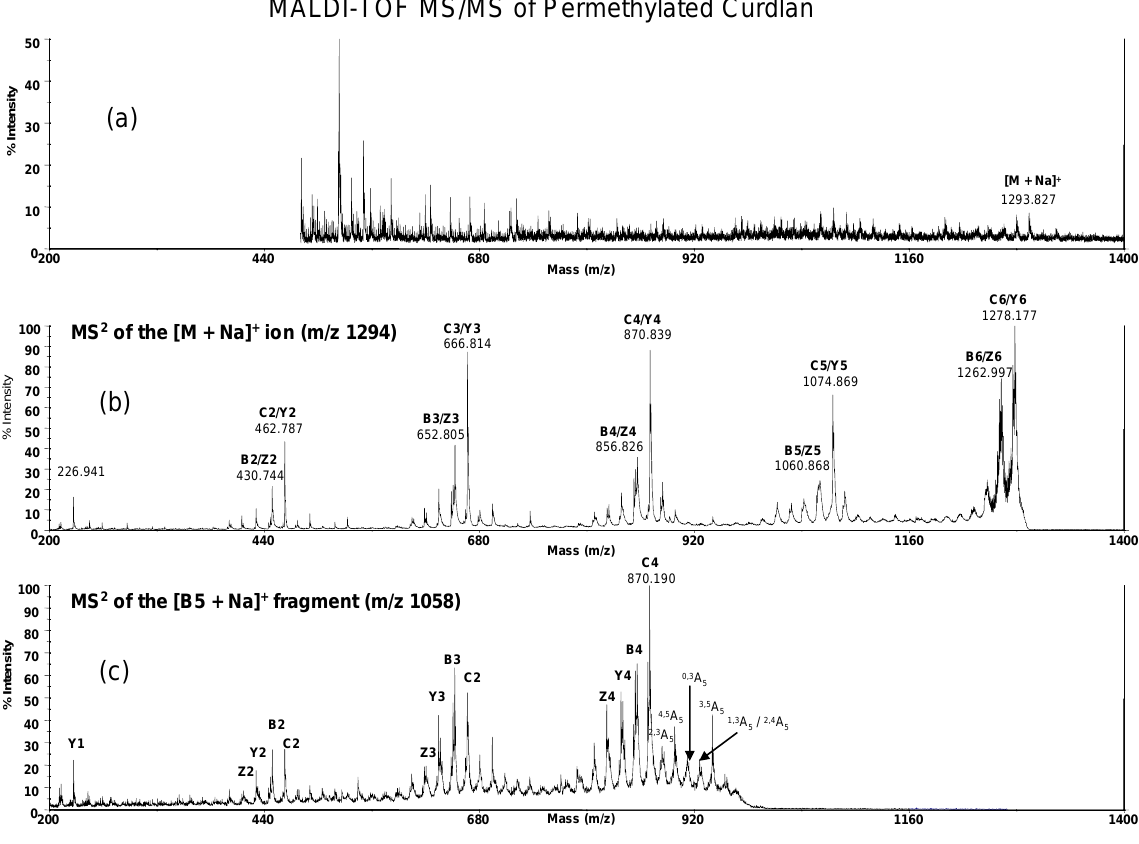
sodiated fragment ion ( m/z = 5 ~C region are 941.0 ( 0,3 A ), 5 4 5